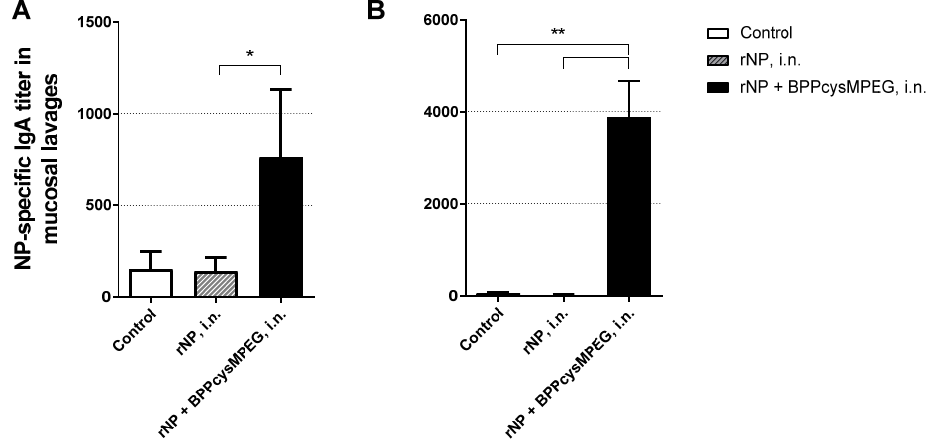
Figure 2. Evaluation of IgA antibody response in mucosal compartments of mice vaccinated with the formulations by i.n. route. NP ‐ specific IgA antibody of ( A ) broncho ‐ alveolar ‐ (BAL) and ( B ) nasal lavages (NL) from mice vaccinated with PBS (control), rNP and rNP co ‐ administered with BPPcysMPEG. The results are expressed as mean endpoint titers with SEM. Statistical analysis between the adjuvanted and non ‐ adjuvanted groups was performed by two ‐ tailed Student’s t ‐ test. Differences were statistically significant (* p < 0.1) and (** p < 0.01) with respect to values obtained in control mice and/or mice receiving rNP alone.